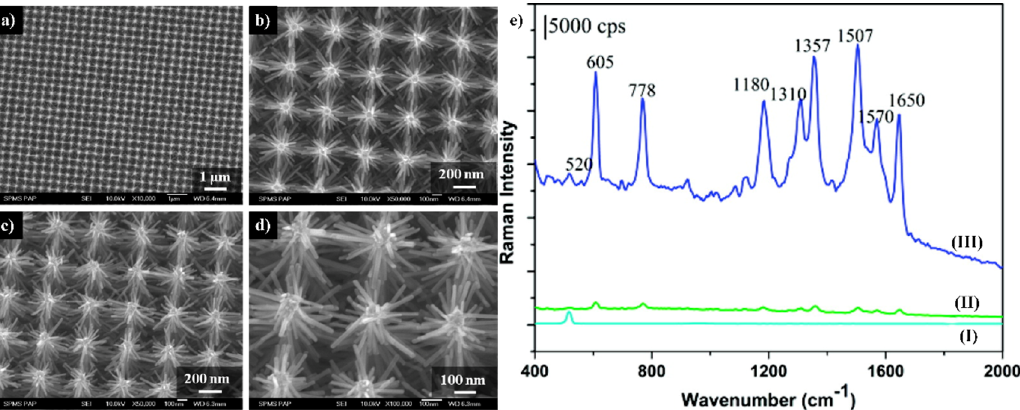
Figure 7. ( a – d ) SEM images of the ordered Si/ZnO nanotrees: ( a , b ) top view, ( c , d ) 20 o titled view, ( e ) SERS spectra of molecules of rhodamine 6G adsorbed from the solution with the concentration of 10 − 6 M collected from: (I) Si/ZnO nanotrees, (II) Ag nanoparticles substrate prepared by the sputtering method, (III) Si/ZnO nanotrees decorated by Ag nanoparticles. Reprinted with permission from [40]. Copyright 2010 American Chemical Society.